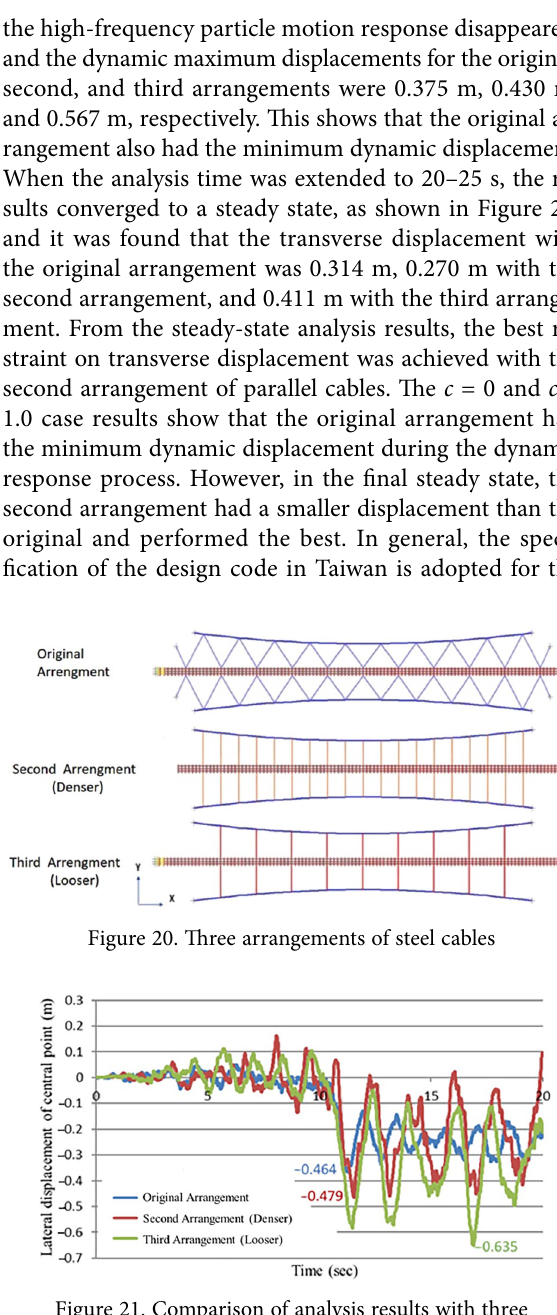
Figure 21. Comparison of analysis results with three arrangements of steel cables ( c = 0)